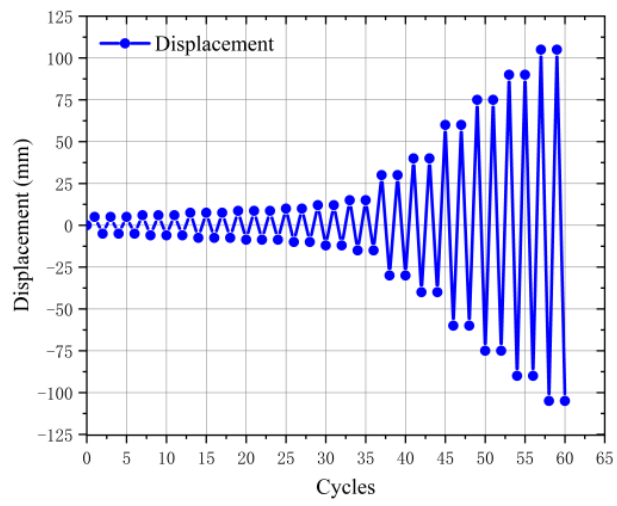
Figure 10. Loading Figure 10. Loading system.